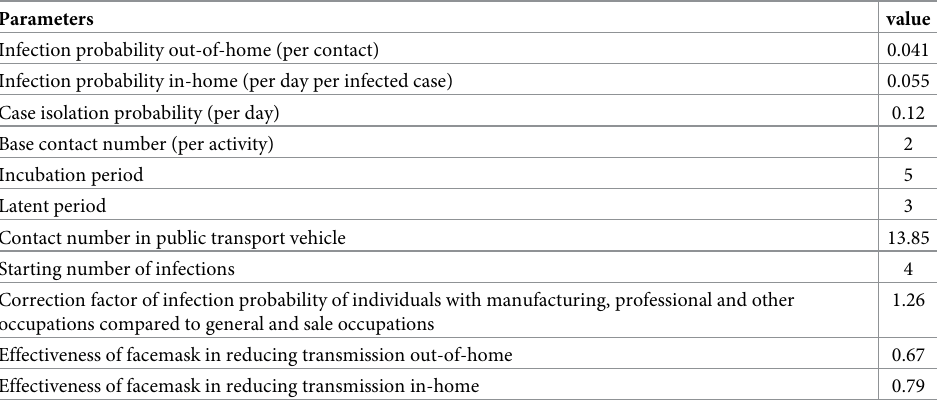
Table 1. Calibrated COVID-19 transmission parameters in the